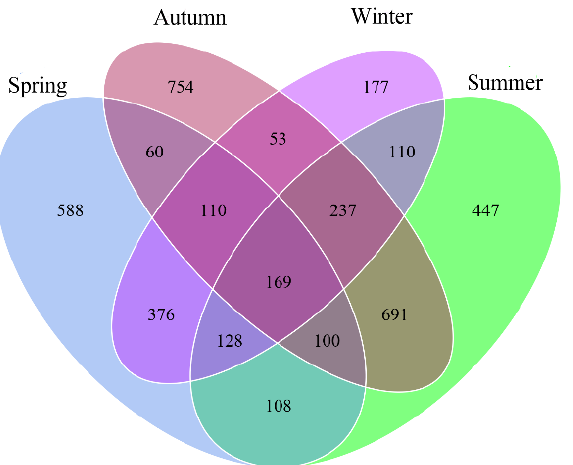
Figure 3. Venn diagram describing the OTU overlap in microbial communities analyzed in the different seasons.